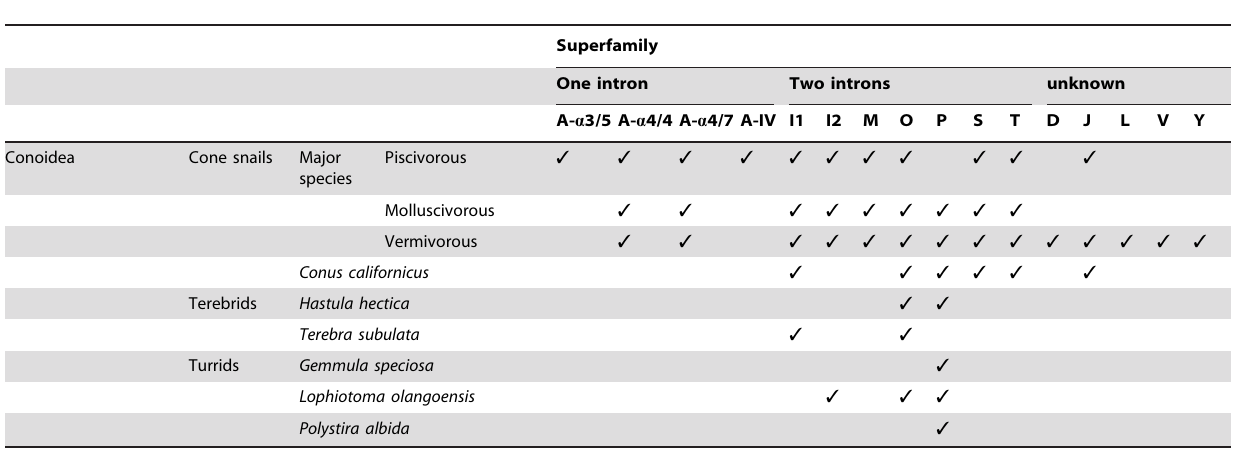
Table 3. Conotoxin superfamily distributions within selected